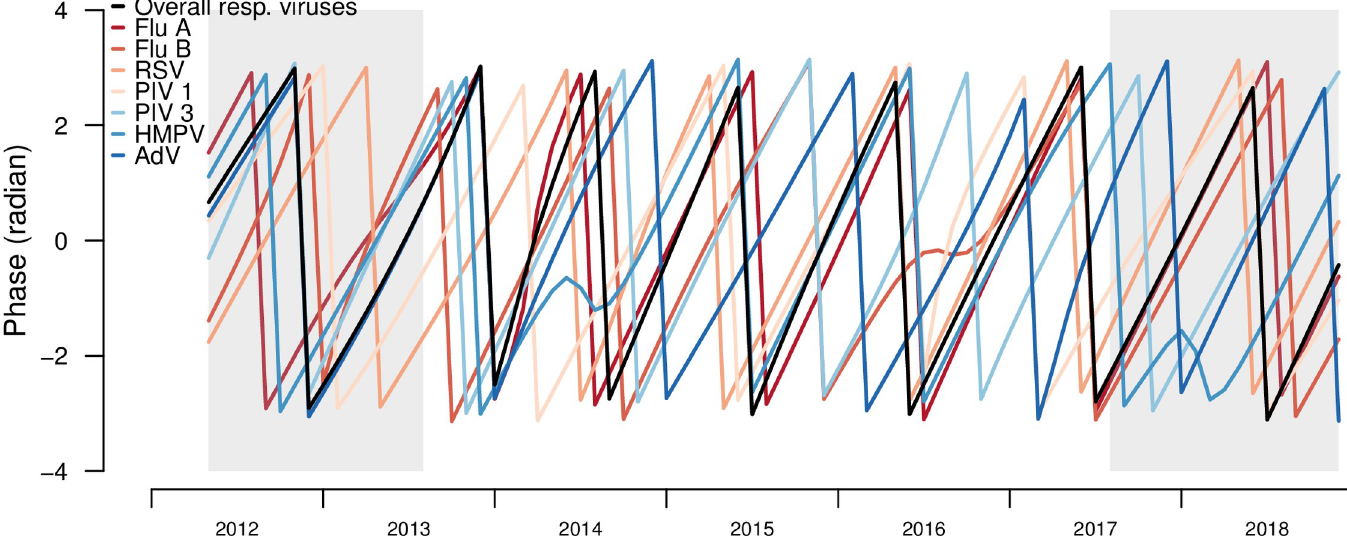
Fig 5. Phase angles of seasonal cycles of total and individual respiratory infections, Sentinel Enhanced Dengue Surveillance System (SEDSS), Southern Puerto Rico, 2012–2018.